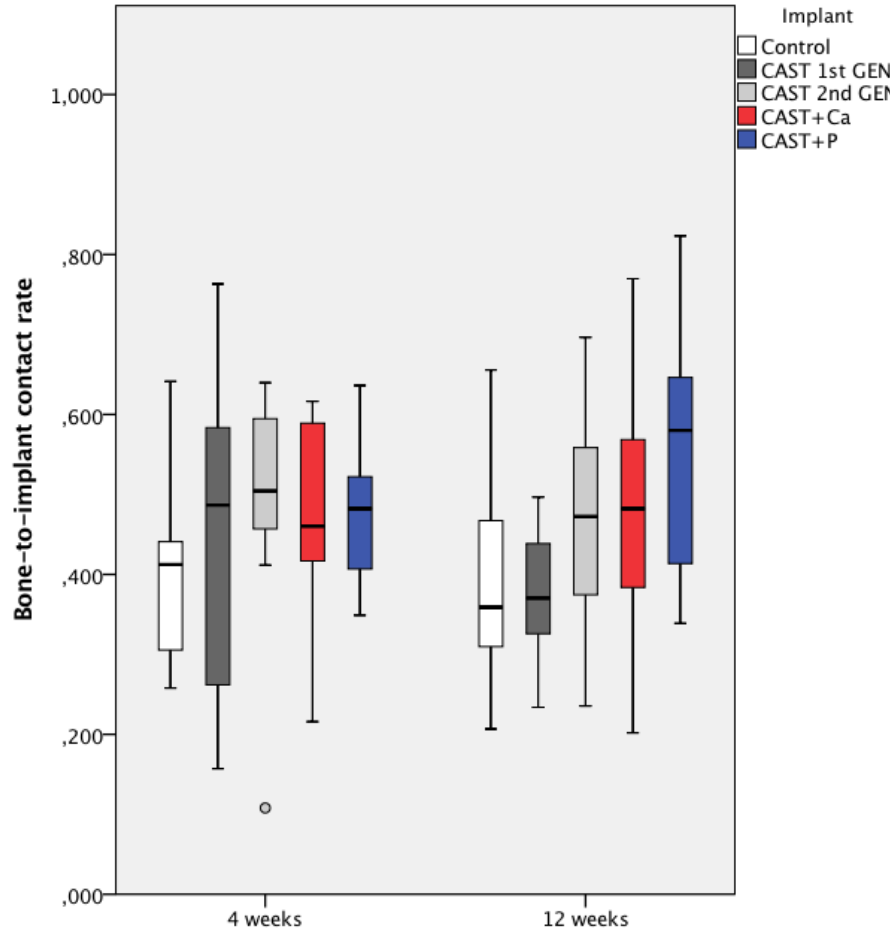
Figure 7. Boxplot of bone-to-implant contact rate (BIC) after 4 and 12 weeks. The 25th and the 75th percentile as well as the median are indicated by the box while the whiskers depict maximum and minimum values. Outlies are plotted as individual dots. There was no significant di ff erence between all five groups after 4 weeks ( p > 0.05), whereas there was a trend towards higher BIC in the CAST + P group after 12 weeks ( p = 0.053, Kruskal–Wallis